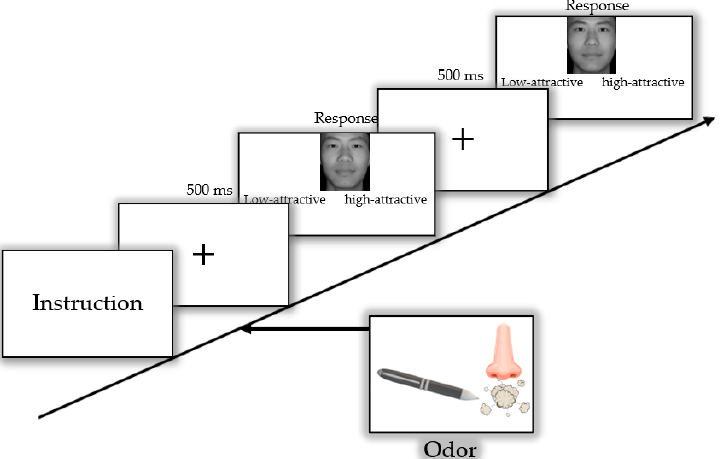
Figure 2. Selection procedure of three (neutral, pleasant, unpleasant) conditions. During the task, participants were asked to indicate whether each face was a high- or low-attractive one. First, they saw a fixation for 500 ms, and then an image was presented. The next trial began immediately after the participant responded.